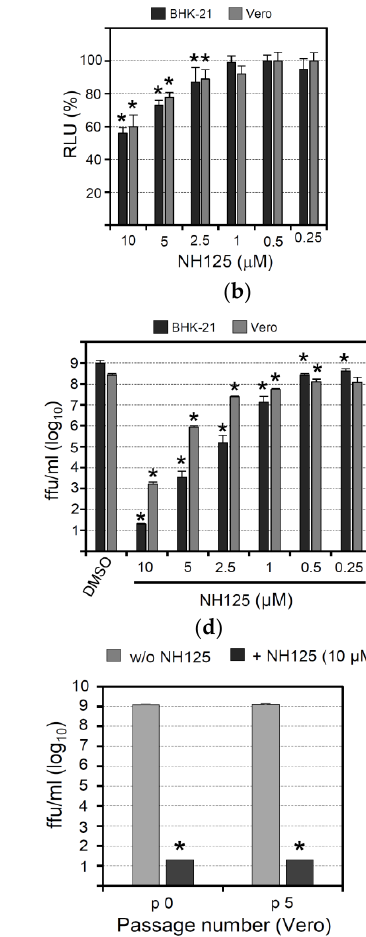
( d ) Figure 1. Effect of selected kinase inhibitors on VSV* Δ G(FLuc)-driven reporter gene expression. The three compounds IKK16 ( a ), ryuvidine ( b ) and NH125 ( c ), which showed >95% suppression of VSV-driven firefly luciferase reporter expression when used at 10 µM (supplementary Table S1), were tested for antiviral activity using lower concentrations (5 µM, 1 µM, and 0.1 µM). Vero cells were treated with the compounds at the indicated concentration for 2 h, inoculated for 1 h with VSV*∆G(FLuc) using an m.o.i. of 0.5 and then further incubated with the indicated compo unds for six more hours. Luminescence emission was determined in cell lysates for 1 s using luciferin as substrate and expressed as relative luminescence units (RLU). Percentage RLU was calculated using the luminescence emission of DMSO-treated cells as reference. Mean values and standard deviations of three infection experiments are shown. Asterisks indicate significant inhibition of infection (compared to DMSO-treated control cells). ( d ) Chemical structure of NH125 [36]. 3.2. NH125 Inhibits Viral Entry by Acting on the Host Cell In order to determine whether NH125 would show inhibitory activity if the cells were treated before, but not during or after virus infection, Vero and BHK-21 cells were incubated for 1 h with NH125 and then inoculated for 1 h (in the absence of NH125) with VSV*∆G(sNLuc), a propagation-defective G gene-deleted VSV expressing secreted NanoLuc luciferase (sNLuc). Subsequently, the cells were incubated with medium containing a VSV-neutralizing antibody in order to limit the virus entry phase to 1 h. The activity of the sNLuc reporter protein secreted into the cell culture medium was determined at 6 h post infection. It turned out that NH125 suppressed